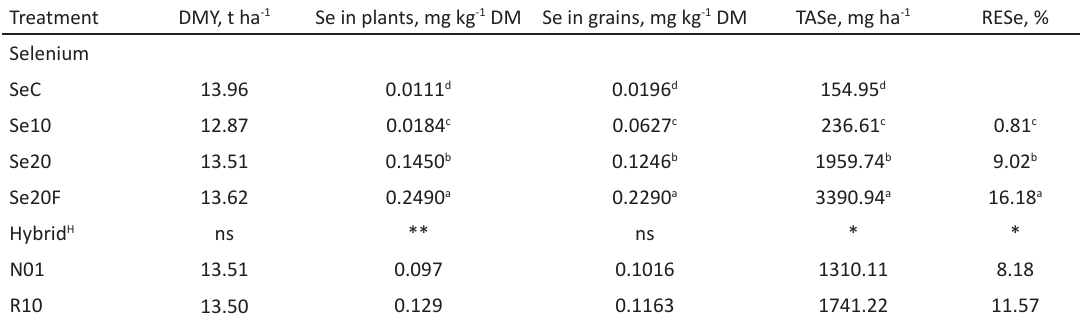
Table 5. Mean comparison of selenium concentrations in maize and biomass yield affected by the main effects of the experimental treatments in 2015 Treatment